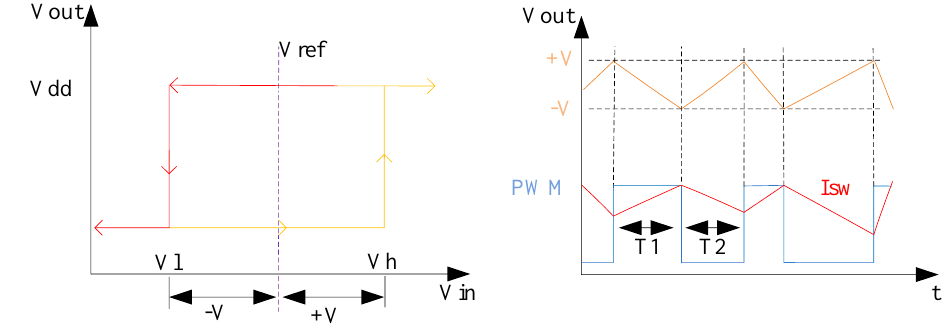
Figure 8. The control logic of the hysteresis comparator.